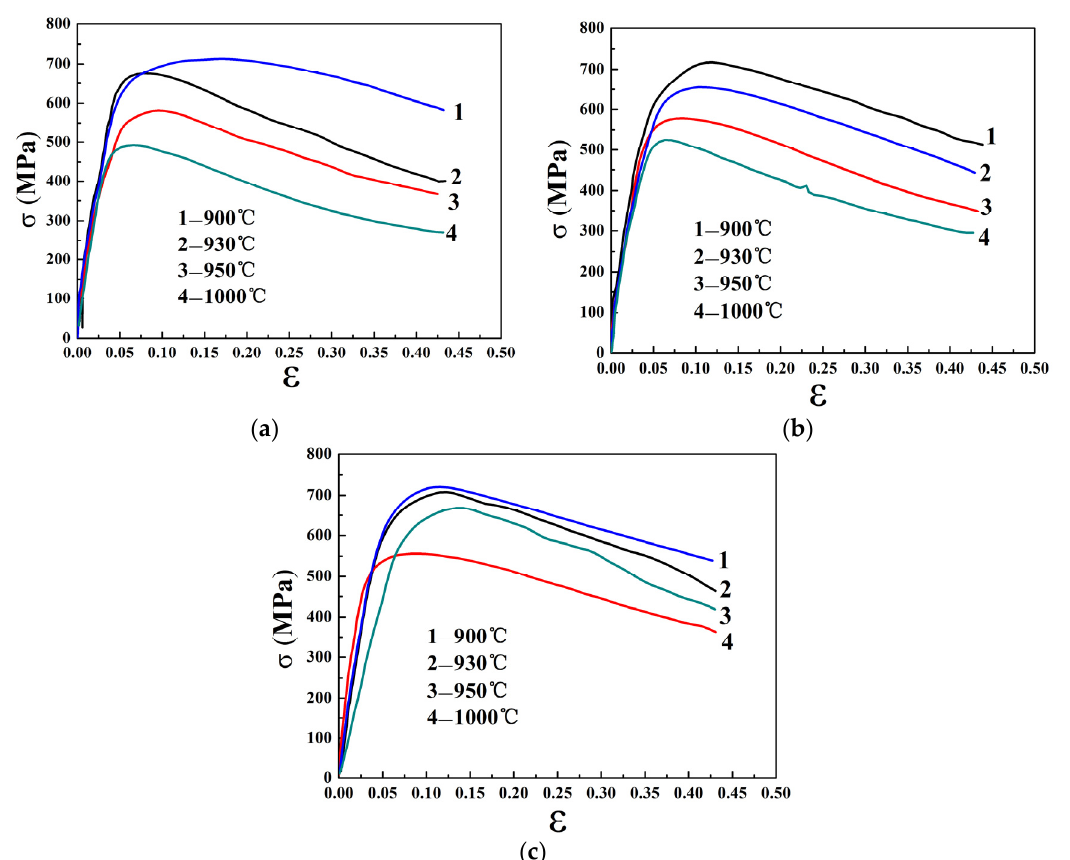
Figure 2. True stress–strain curves of TiAl alloy at different strain rates: ( a ) 0.005 s − 1 ; ( b ) 0.01 s − 1 ; ( c ) 0.05 s − 1.